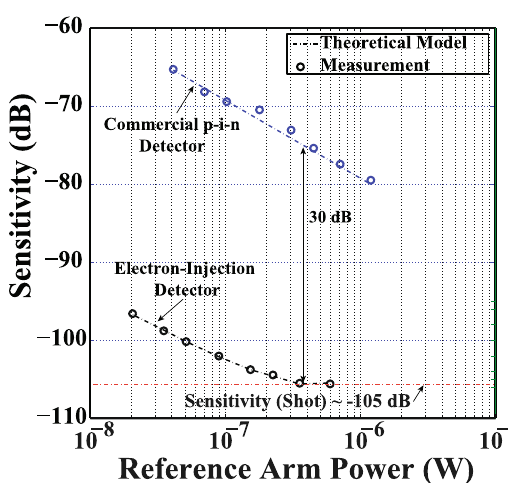
Figure 3. Comparison of the measured and the theoretically calculated sensitivity as a function of the reference arm power for two single-ended detection schemes (electron-injection detector and the commercial p-i-n detector). The symbols are experimental data and curves are theoretically calculated. Electron-injection detector yields ~30 dB higher sensitivity compared with the commercial p-i-n detector. Sample power at the electron-injection detector was ~160 pW. The gain in our device amplifies shot noise and allows it to surpass amplifier noise at a factor of G 2 lower reference power level compared to the p-i-n diode. EI reaches shot noise limited sensitivity of ~ − 105 dB at reference power level of 350 nW. This is, to best of our knowledge, the lowest reference power ever achieved for a shot-noise-limited operation in swept laser source OCT. Furthermore, this is first report of shot-noise-limited performance, without the use of balanced detection in swept source